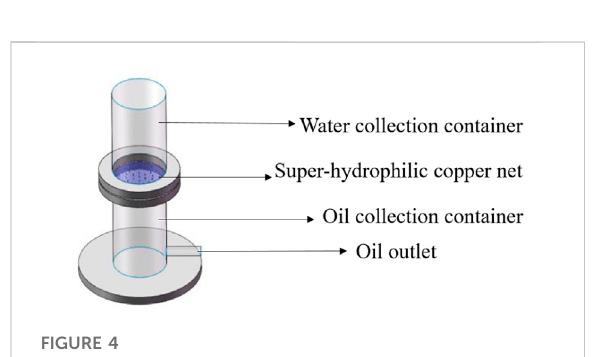
FIGURE 4 Schematic diagram of the oil – water separation device.